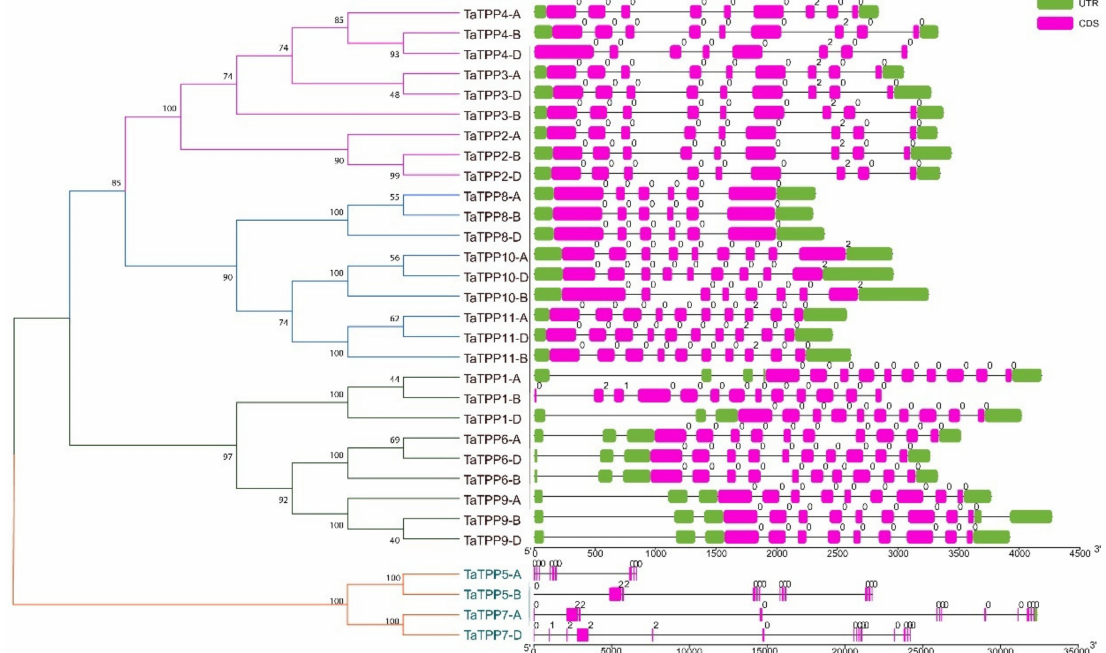
Figure 5. Structural organizations of TaTPPs . The introns are shown by black lines, whereas the exons are represented by pink boxes and untranslated regions (UTRs) are represented with green boxes. Intron phase, 0: phase 0, 1: phase 1 and 2: phase 2 denotes that a codon is not disrupted by introns, a codon between the first and second bases is disrupted by an intron and a codon between the second and third bases is disrupted by an intron,